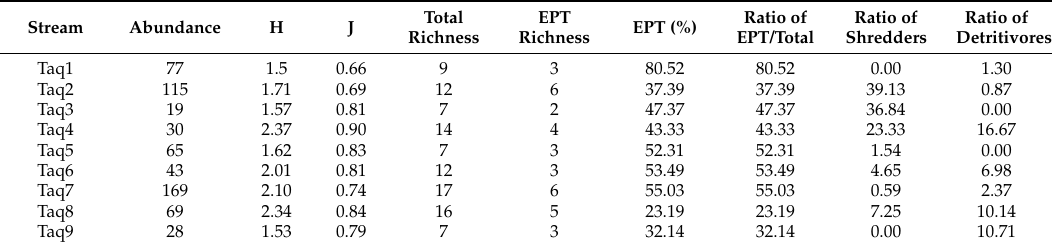
Table 5. Biological metrics of the macroinvertebrate fauna for the nine streams of Taquaruçu Grande river basin, State of Tocantins, Brazil. H: Shannon-Weiner index of diversity. J: Pielou index. EPT: Ephemeroptera, Plecoptera, and Trichoptera. Stream